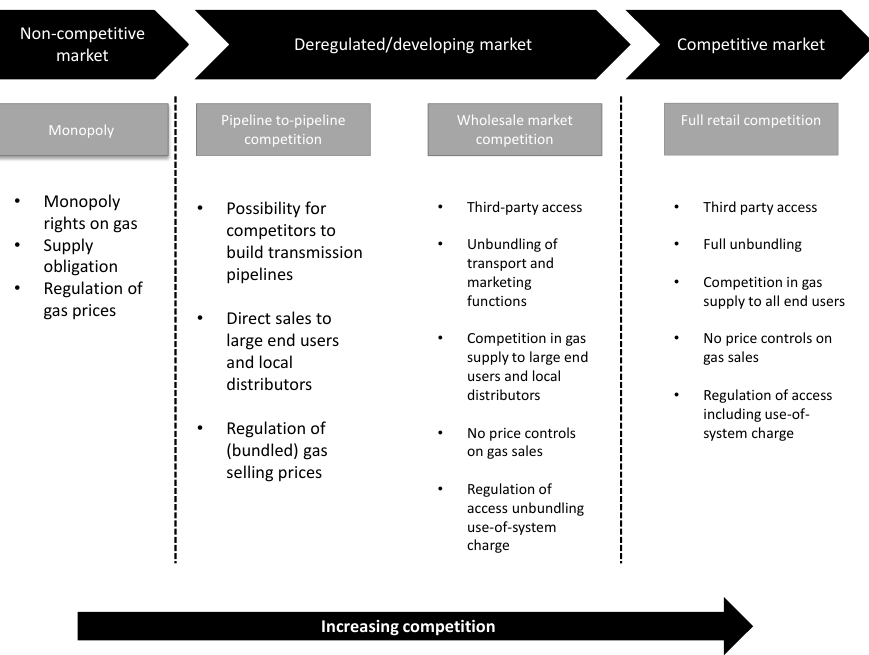
FIGURE 2: Framework to increase competition in the natural gas market Source: Kate et al.